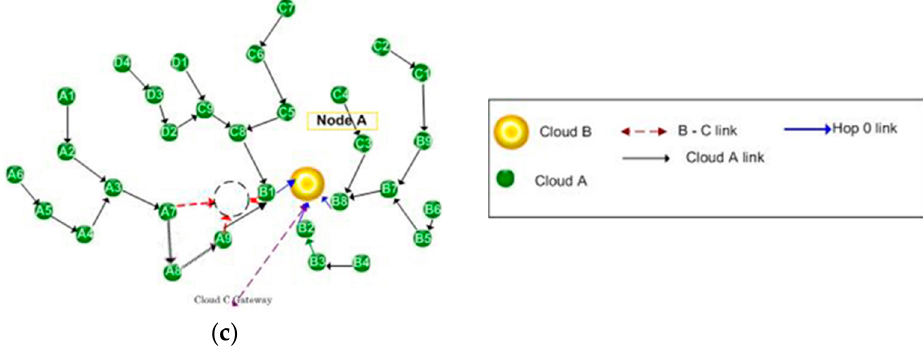
Figure 8. Network formations for the example of Figure 7. ( a ) typical IEEE 802.15.4 clustered peer-to-peer ad hoc formation in the absence of a node; ( b ) network structure as one node appears; ( c ) network restructuring as the node moves into a new position.